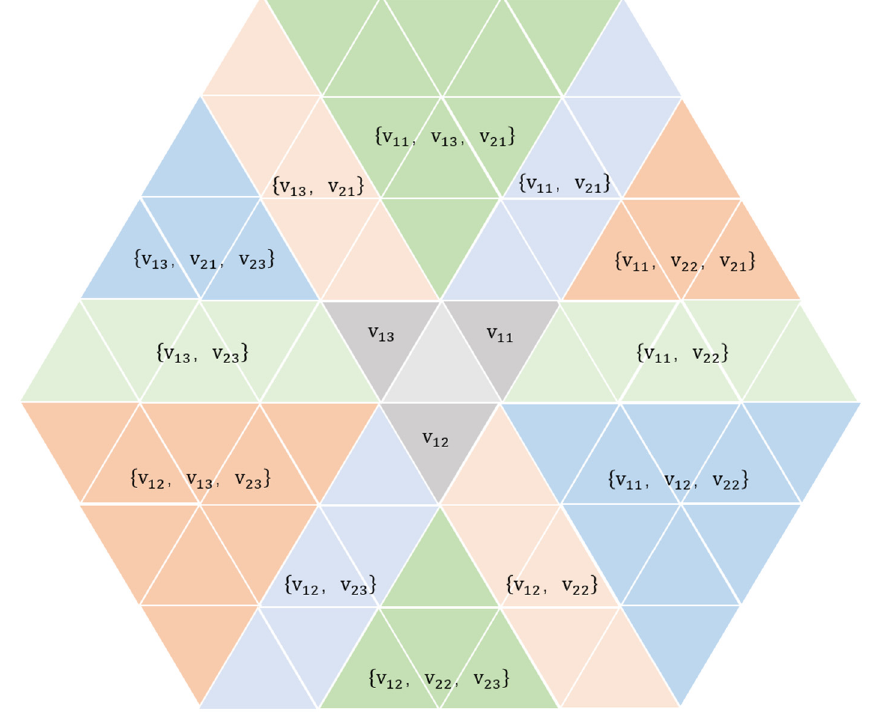
Figure 2. The grid’s expansion complex unit distribution map. Table 2. Correspondence between the (x, y, z) value and the expansion complex